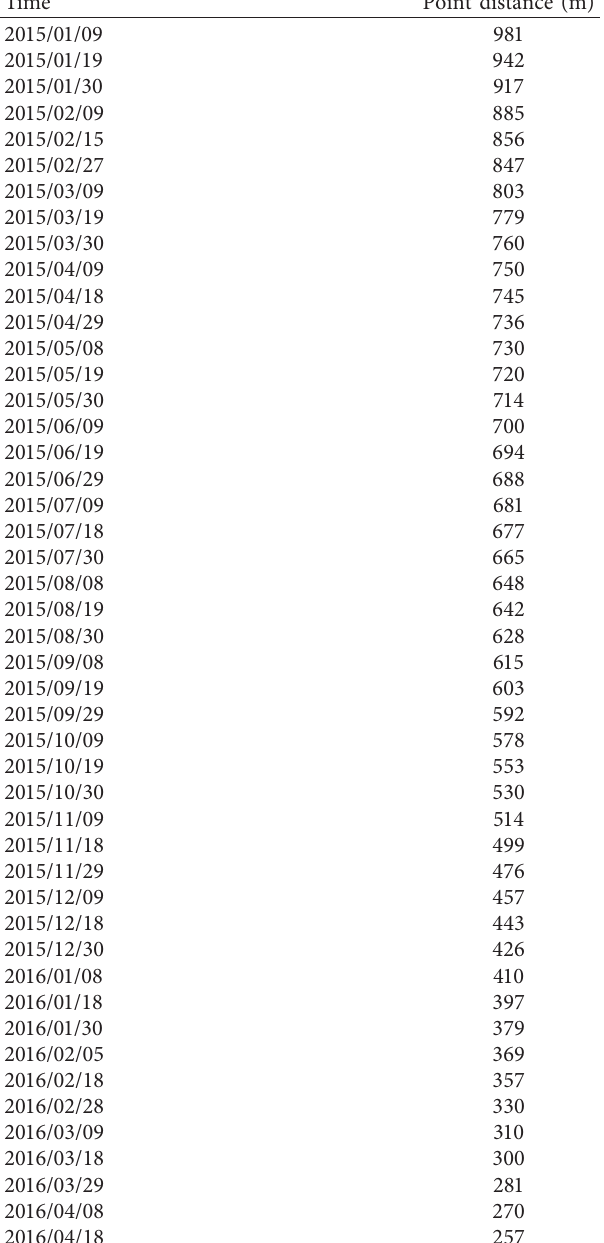
Table 1: Some parts of advancing progress of working face #22517.